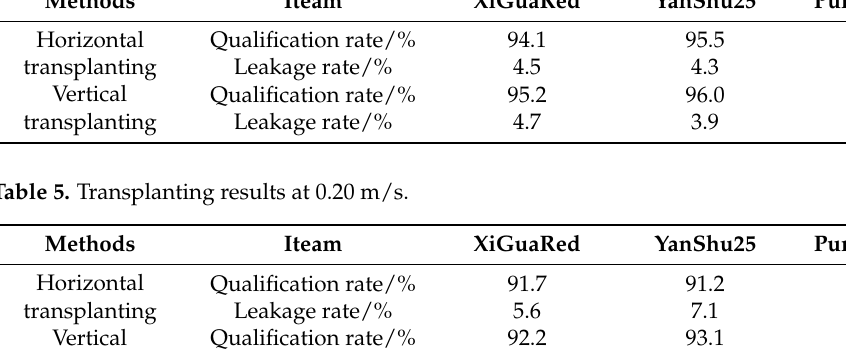
Table 5. Transplanting results at 0.20 m/s.